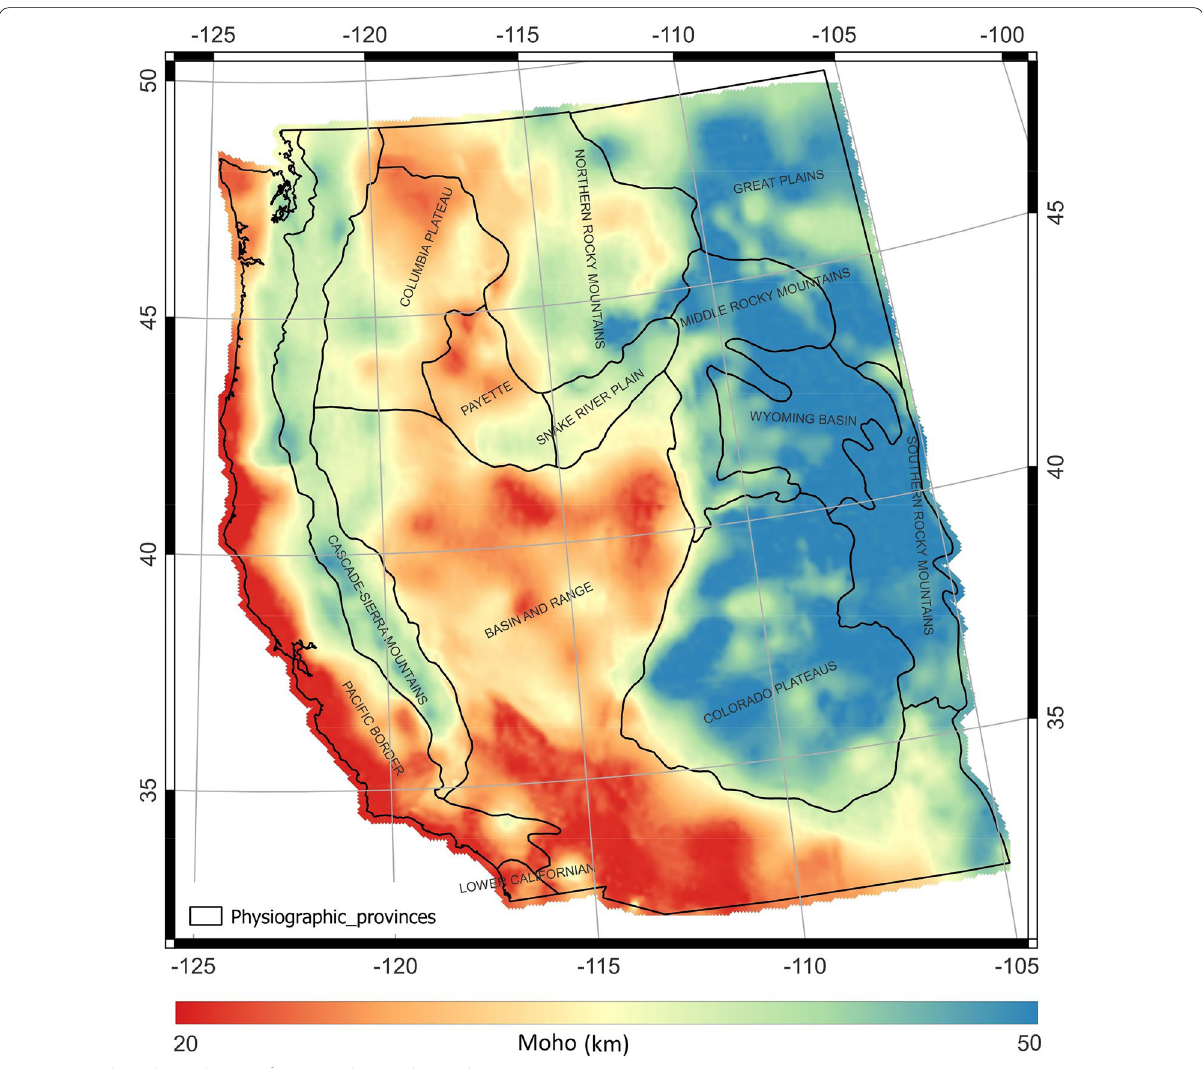
Fig. 6 Depth to the Moho interface map (km) in the study